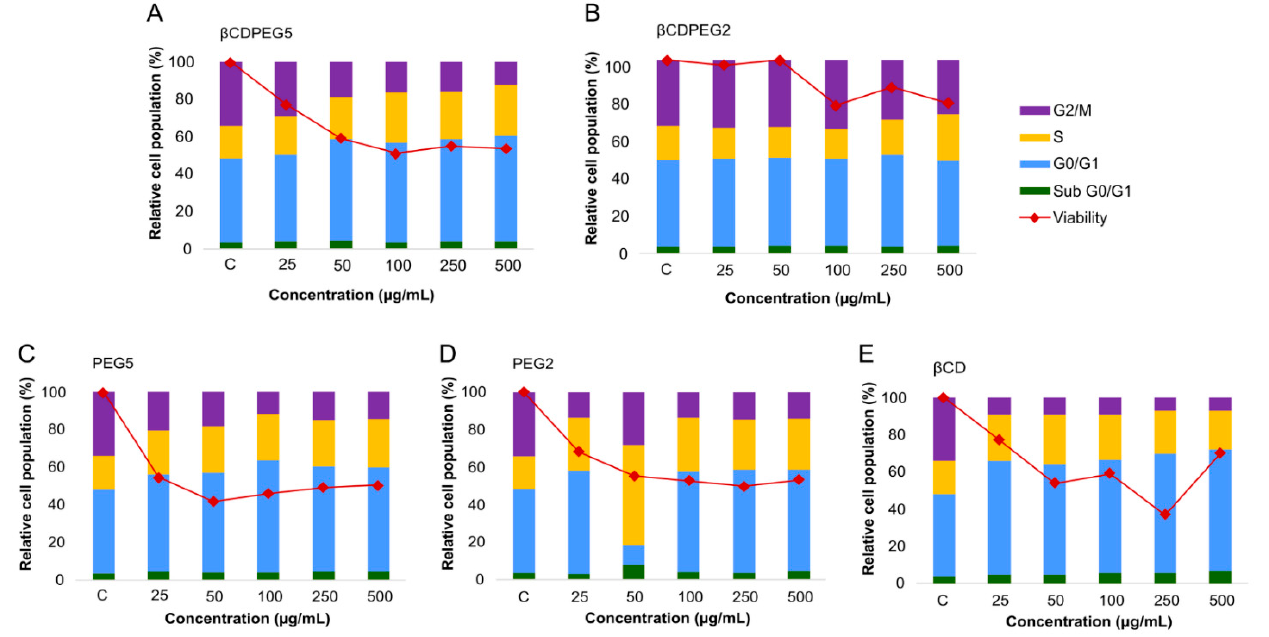
Figure 4. Effects of ( A ) β CDPEG5, ( B ) β CDPEG2, ( C ) PEG5, ( D )PEG2, and ( E ) β CD on the cell cycle of MC3T3-E1 osteoblasts. Viability refers to the % cell viability reported in Section 2.2.1., which was included to facilitate comparison with % relative cell population.